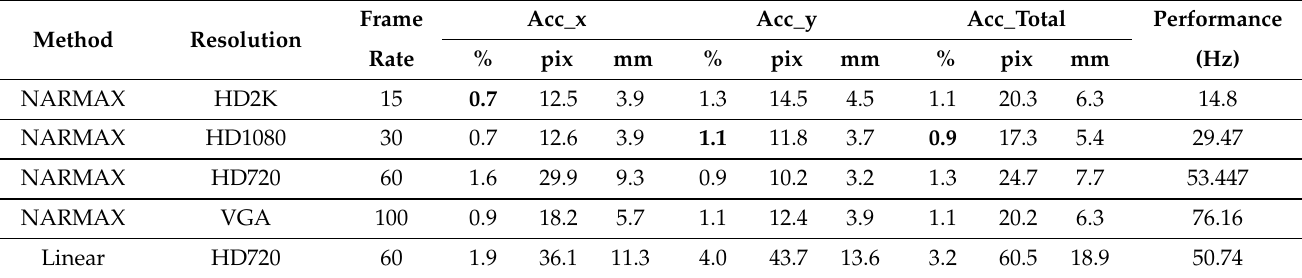
Table 1. Testing accuracy vs. camera parameters on a 1920 × 1080 screen using NARMAX calibration method. Test done by one person looking at eight points on a screen. Test was done 5 times.